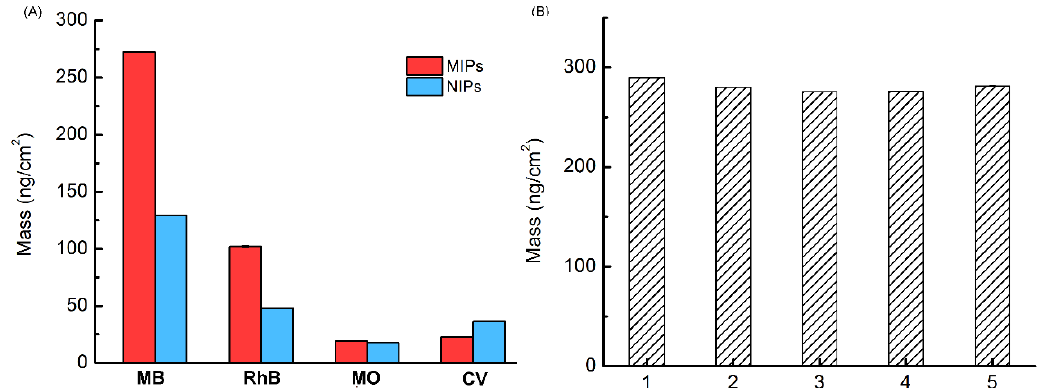
Figure 8. ( A ) Changes in mass of the quartz crystal microbalance with dissipation monitoring sensors coated with molecular imprinted polymers (MIPs) and non-imprinted polymers (NIPs) in the presence of methylene blue (MB), rhodamine B (RhB), methyl orange (MO), and crystal violet (CV). ( B ) Reproducibility of the change in mass of the quartz crystal microbalance with dissipation monitoring sensor coated with MIPs in response to the presence of 150 µg/L of MB. Mean value ± standard deviation, n = 3.